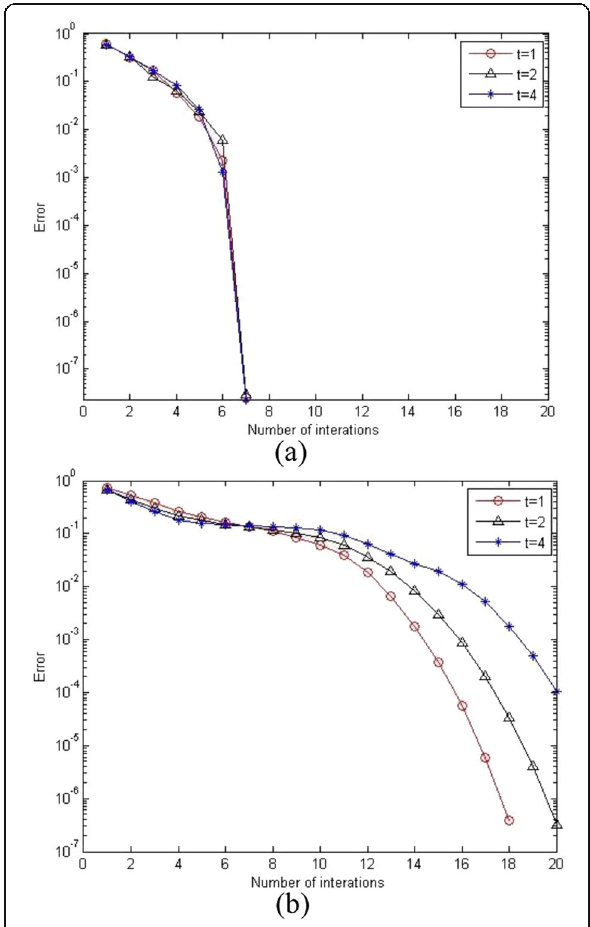
Fig. 2 Comparison of the rates of convergence for different dimensions of measurement matrices ( M = 128, N = 256, ρ = 0.8). Frame a was obtained from l 0 -norm minimization with k = 40. Frame b was obtained from l 0 -norm minimization with k = 60. In frame a and b , t = 1, 2, 4 mean the dimensions of the measurement matrices are 128 × 256, 64 × 128, and 32 × 64,